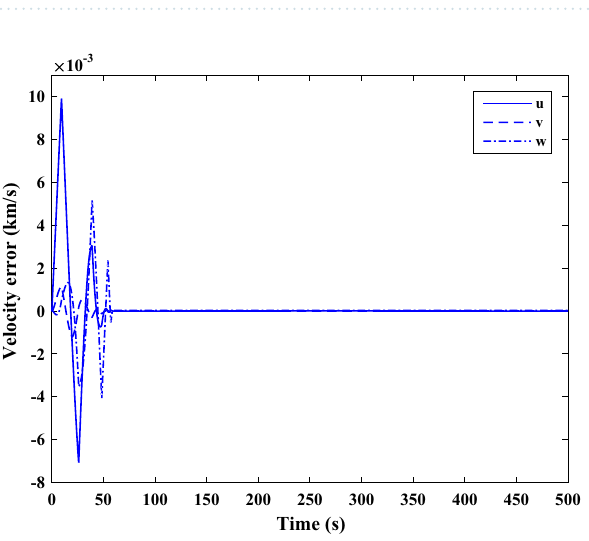
Figure 58. Scenario III: linear velocity tracking (in desired frame).